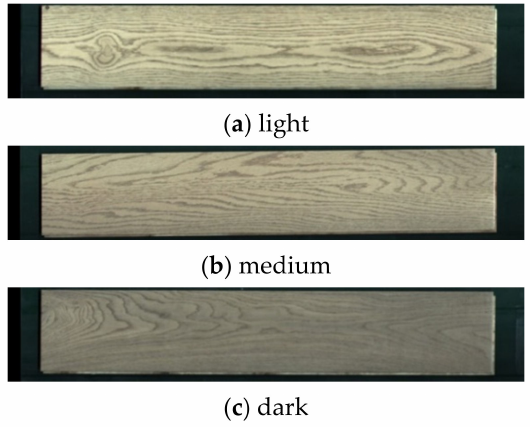
Figure 2. Solid wood floors with three color grades: light, medium, and